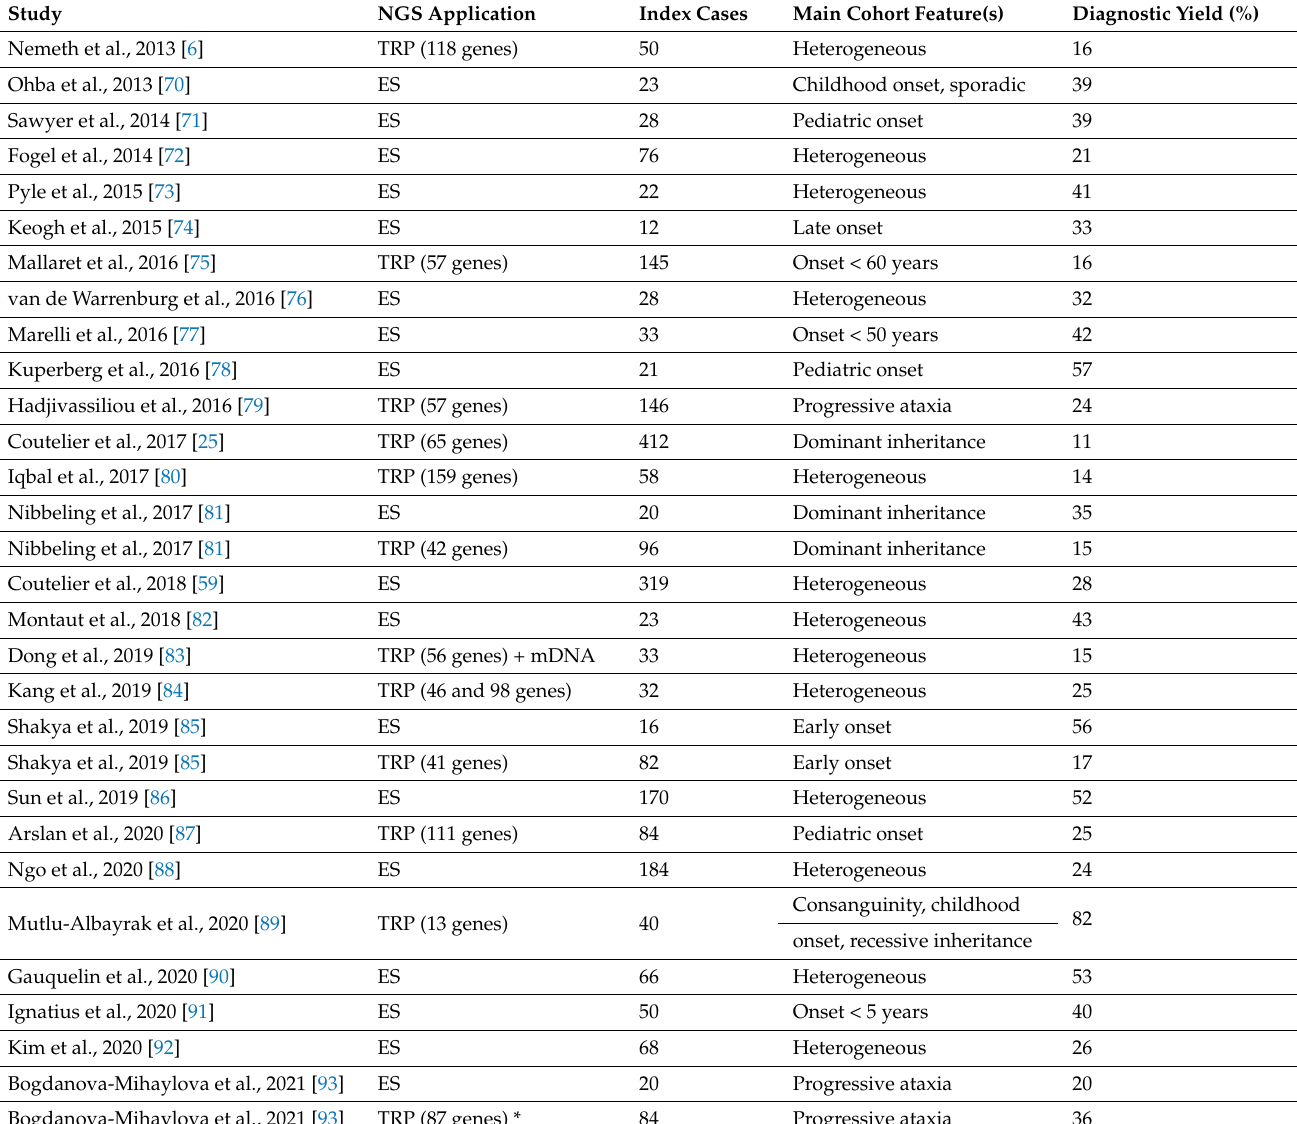
Table 2. Ataxia-cohort studies published so far in